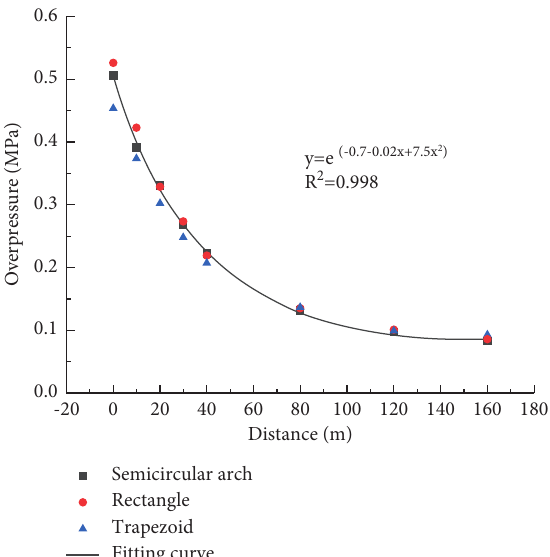
Figure 14: Changes of overpressure in the cut eye of the working face with different cross-sectional